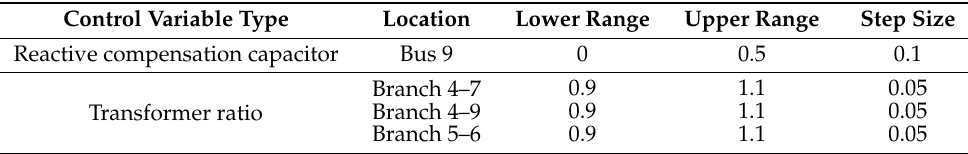
Figure 8. IEEE 14-bus test system. Table 2. The capacitor and transformer parameters of the IEEE 14-bus test system.